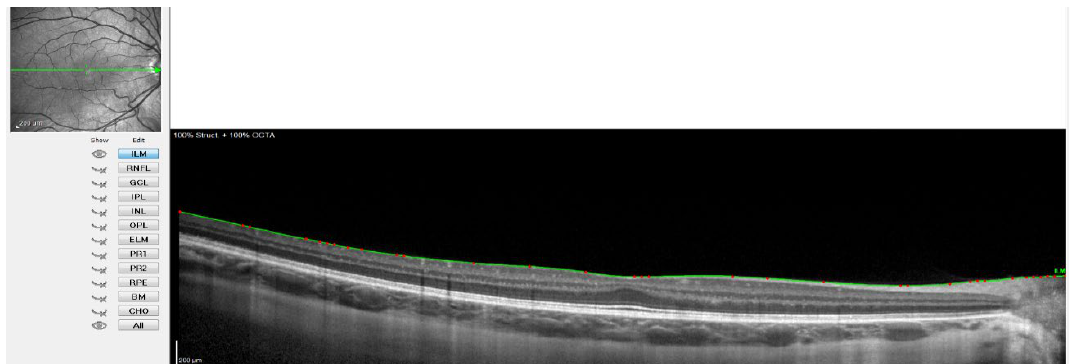
Figure 2. OCT image with the line of the internal limiting membrane marked in green, point by point.